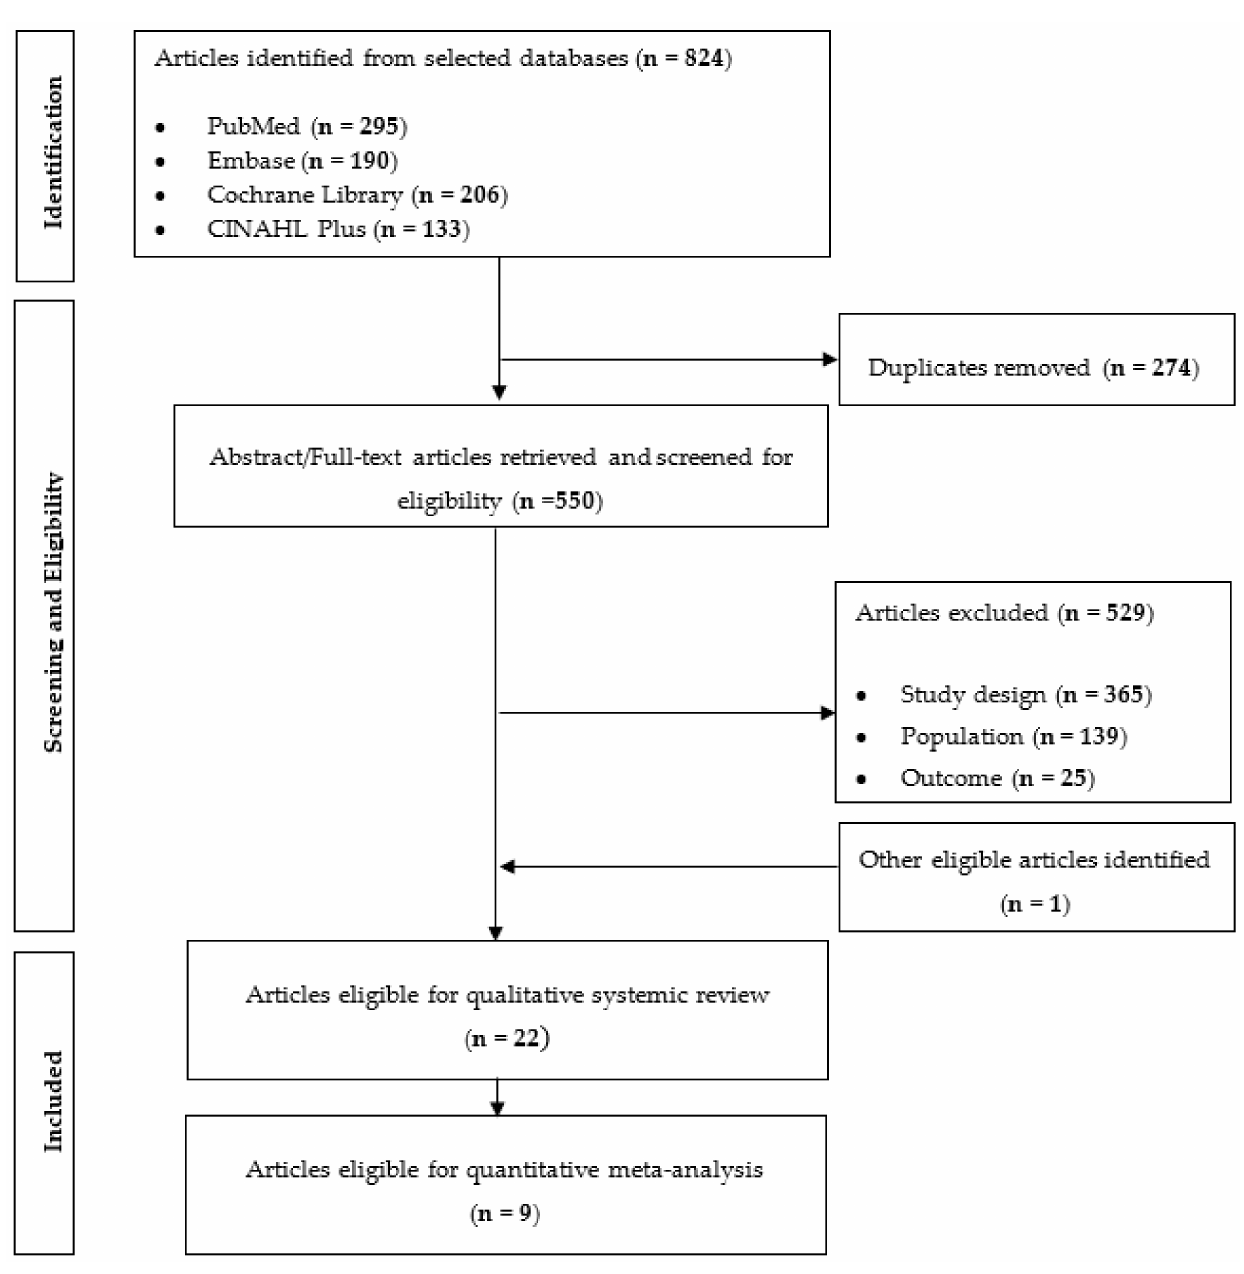
Figure 1. Flow diagram of article search and screening process showing the number of studies assessed for eligibility and included in the review for cardiometabolic health related clinical